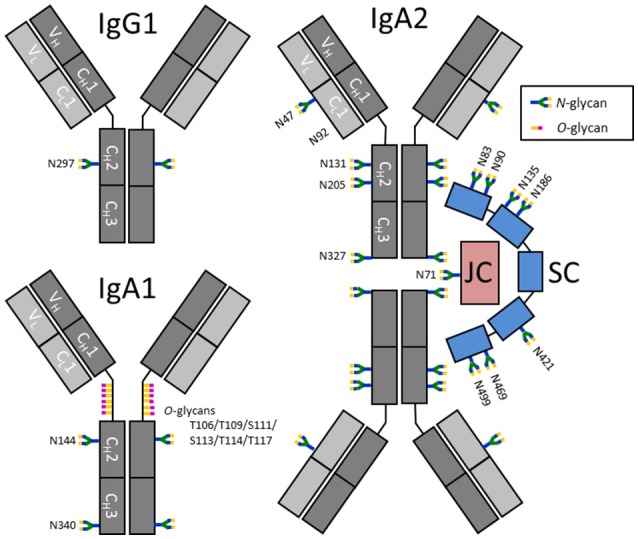
Schematic representation of IgG1, IgA1, and SIgA2 and their glycosylation sites. IgA2 is shown in its dimeric form, in a complex with a joining chain (JC; red) and a secretory component (SC; blue). The JC and SC are covalently linked to IgA by disulfide bonds (not shown). Each Ig monomer is composed of two heavy chains (dark gray) and two light chains (light gray), again connected by disulfide bonds. The chains are further subdivided as constant (C) and variable (V) domains. N-glycosylation sites on IgG are indicated by their amino acid number according to the nomenclature used by conventional literature, e.g., (24), while IgA, the JC and SC have UniProt numbering (25). N92 on IgA2 was previously reported to be glycosylated, however, N92 on the IgA2 allotype found in our samples [A2m(1)] was not incorporated in a N-glycosylation consensus sequence and was found to be non-glycosylated.